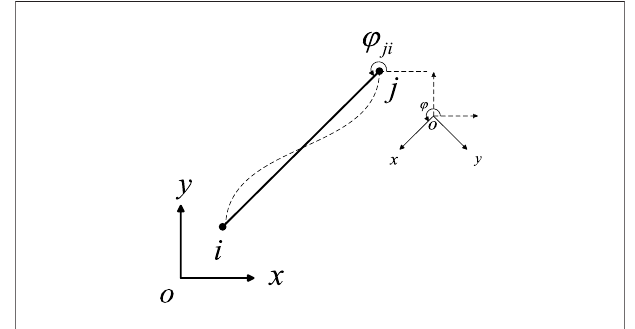
FIGURE3| Globalcoordinatesystemrotationdiagram(point j topoint i